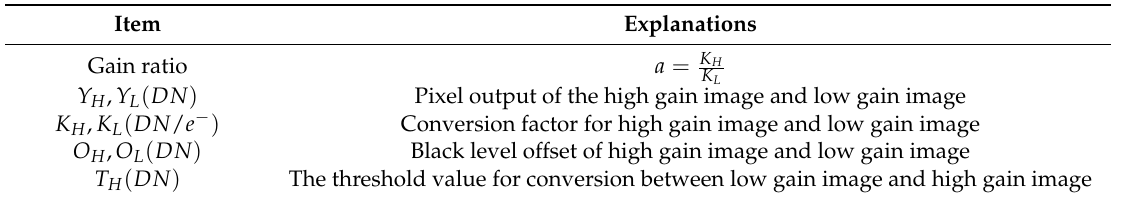
Table 3. Parameters and physical meanings in formula 3.